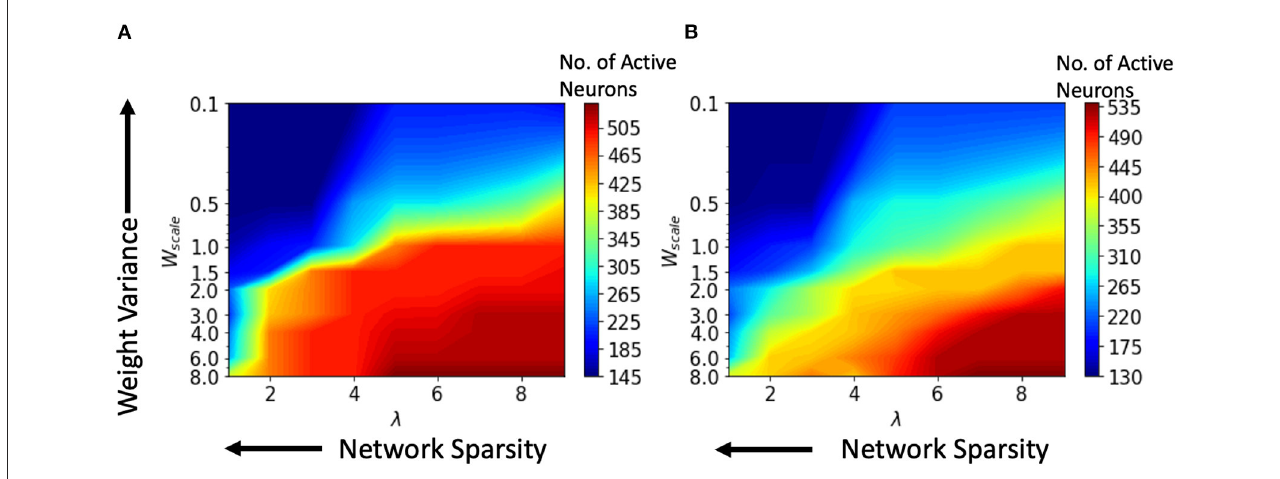
FIGURE5 Change in the number of active neurons with network sparsity and weight variance, for (A) HoNHoS and (B) HeNHeS. The plot is obtained by interpolating 81 points, and each point is calculated by averaging the results from 5 randomly initialized HRSNNs.